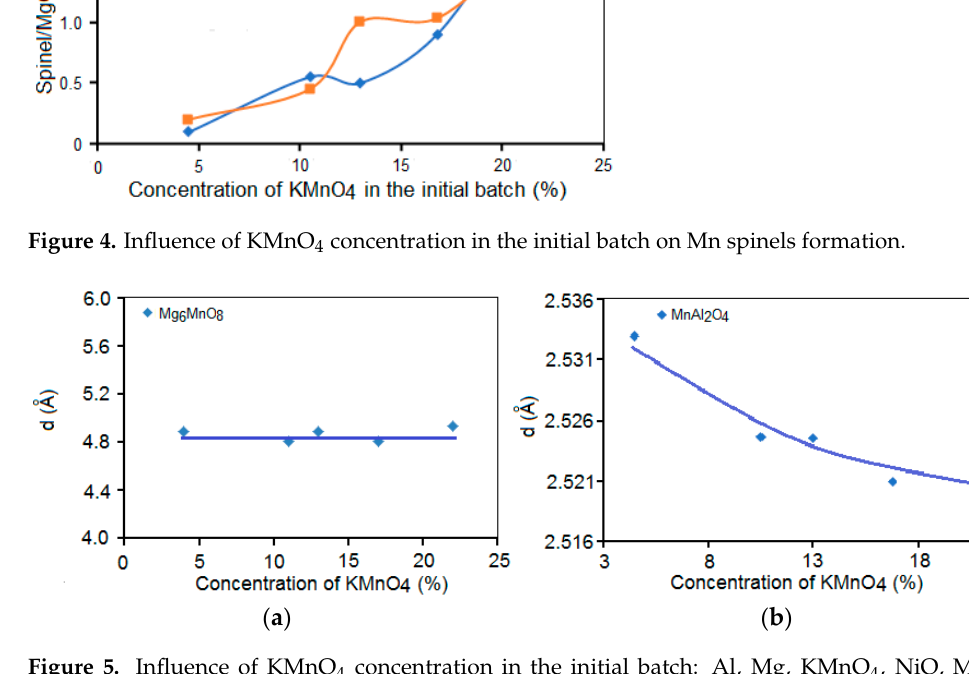
Figure 5. Influence of KMnO 4 concentration in the initial batch: Al, Mg, KMnO 4 , NiO, MgO, Mg (NO 3 ) 2 , Al 2 O 3 on the Mg 6 MnO 8 ( a ) and MnAl 2 O 4 ( b ) crystal lattice planes parameters in SHS catalysts.